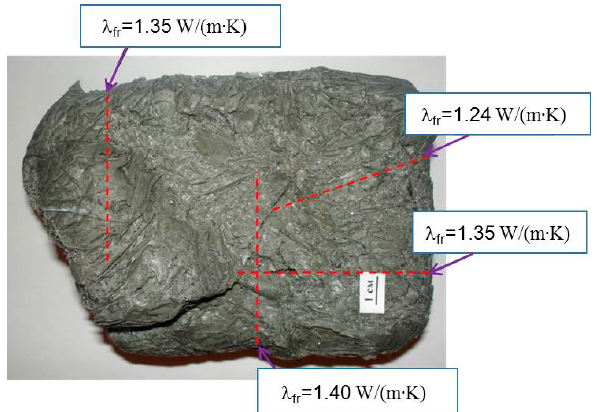
Figure 6. Thermal conductivity of the mud sample (S-1) measured in different directions.